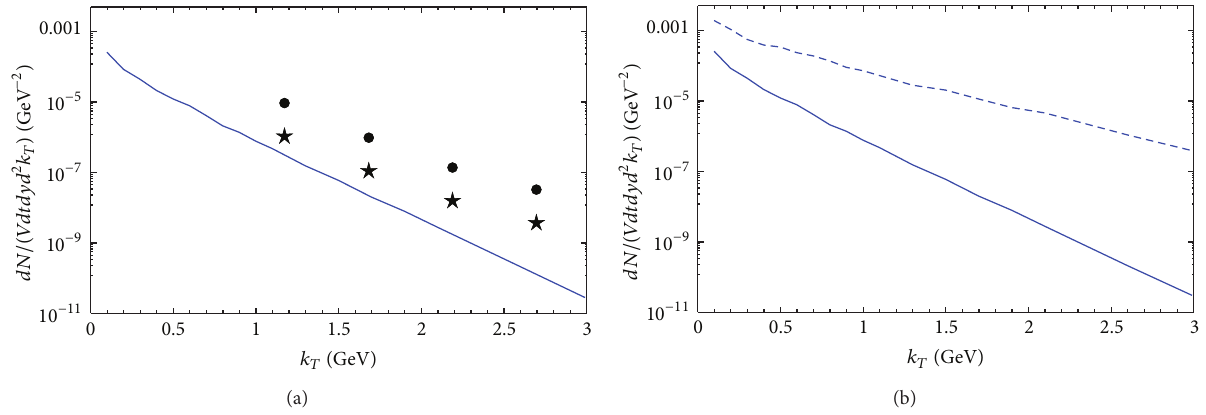
Figure 18: Azimuthal average of the synchrotron radiation spectrum of 𝑢 , 𝑑 , 𝑠 quarks and their corresponding antiquarks. (a) 𝑒𝐵 = 𝑚 2 𝜋 , 𝑦 = 0 compared to the experimental data from [8] divided by 𝑉𝑡 = 25𝜋 fm 4 (dots) and 𝑉𝑡 = 9 × 25𝜋 fm 4 (stars); (b) 𝑒𝐵 = 𝑚 2 𝜋 , 𝑇 = 200 MeV, and 𝑦 = 0 (solid line) compared to 𝑒𝐵 = 15𝑚 2 from